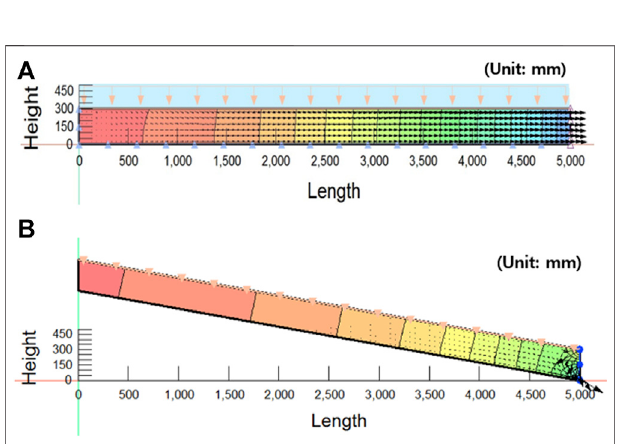
FIGURE 3 | Interface of the SEEP/W model for the simulation of green roof systems: (A) without a slope; (B) with a slope of 10 degrees.